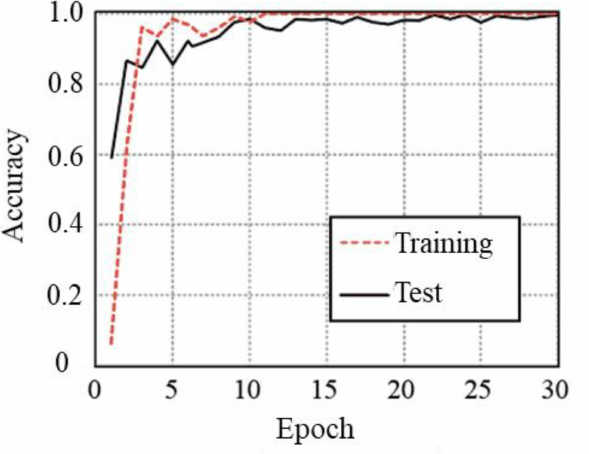
Figure 7. Example of convergence curves for STFT with N = 25 and W L = 32